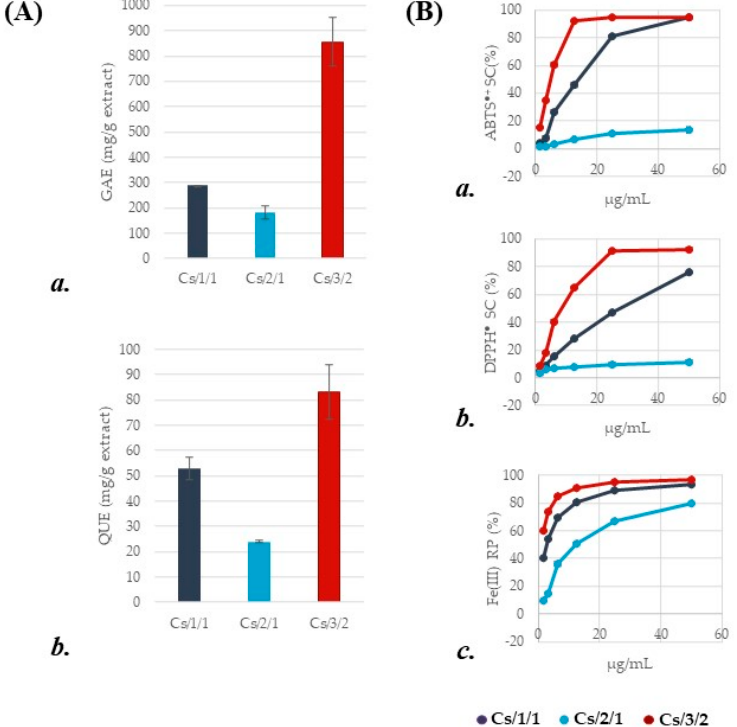
Figure 2. ( A ) ( a ) Total phenolic content (TPC), expressed as mg of gallic acid equivalents (GAEs) per g of extract; ( b ) total flavonoid content (TFC), expressed as mg of quercetin equivalents (QUEs) per g of extract. Values reported are the mean± SD of three independent measurements. ( B ) ( a ) Scavenging capability (SC%) vs. 2,2 ′ -azino-bis(3-ethylbenzothiazoline)-6-sulfonic acid (ABTS) radical cation; ( b ) scavenging capability (SC%) vs. 2,2-diphenyl-1-picrylhydrazy (DPPH) radical, and ( c ) Fe(III) reducing power (RP%) of C. sativa extract and organic fractions therefrom. Values reported are the mean ±SD of three independent